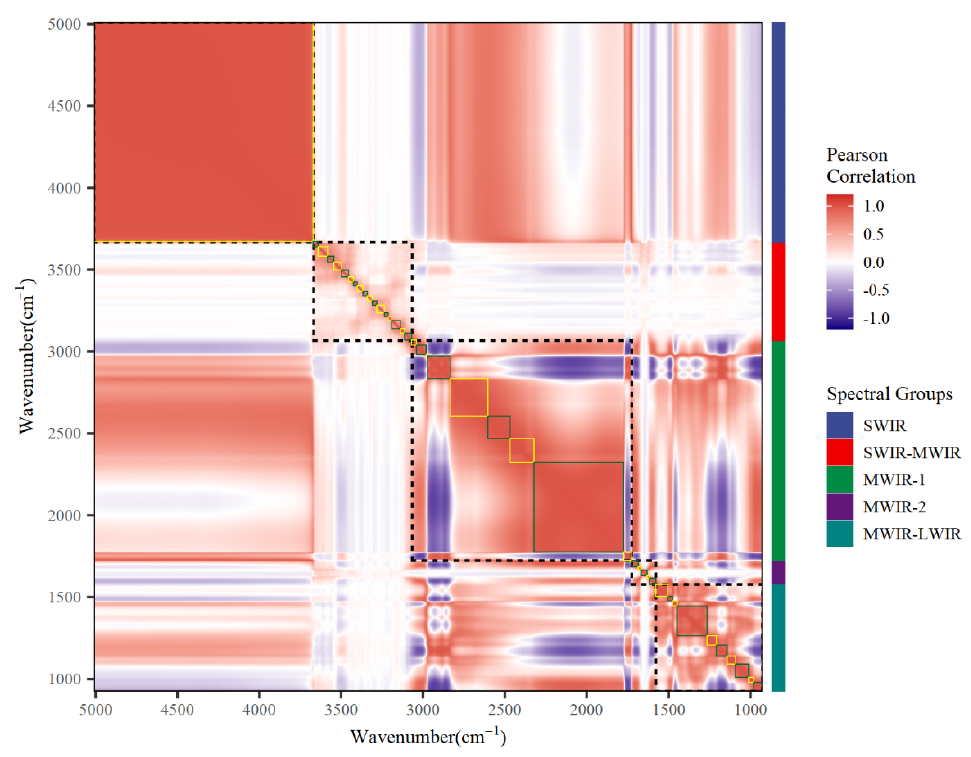
Figure 1. The correlation heatmap of wavenumber absorbances across 1060 wavenumbers ranging from 5010.15 to 925.66 cm − 1 . SWIR, short-wavenumber infrared or near-infrared; MWIR, mid-wavenumber infrared; LWIR, long-wavenumber infrared.